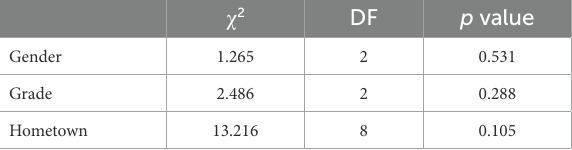
TABLE 3 Testing for non-response bias.